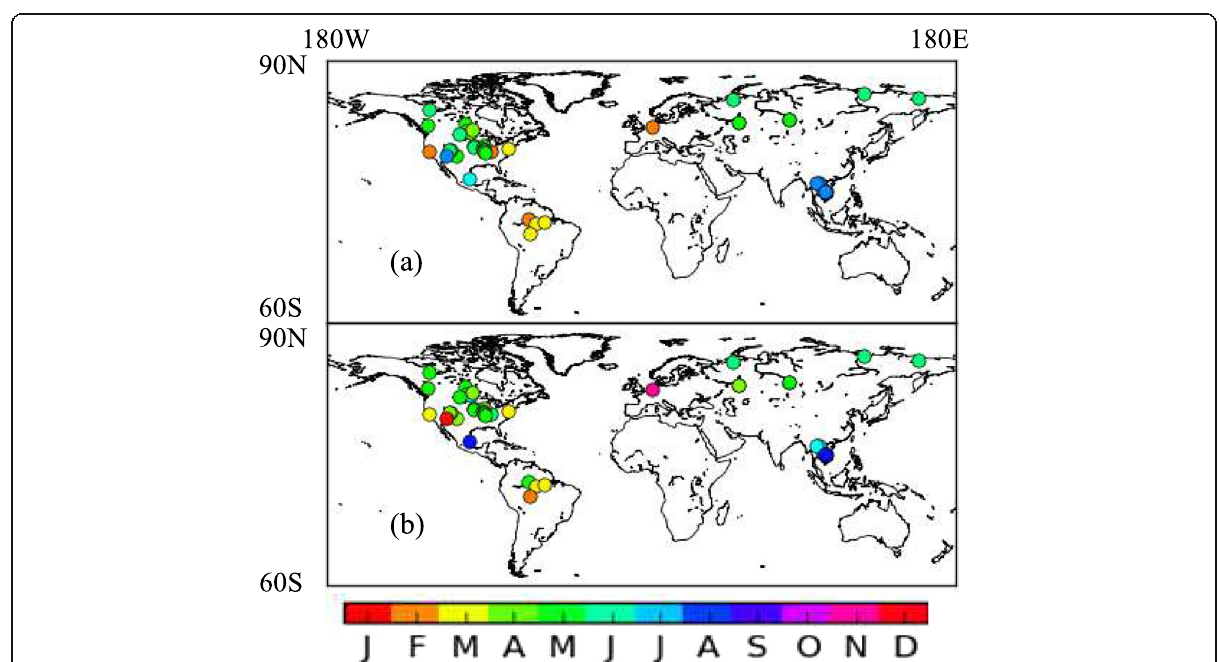
Fig. 5 Month with the maximum suspended sediment flow. a Observation and b CTL simulation